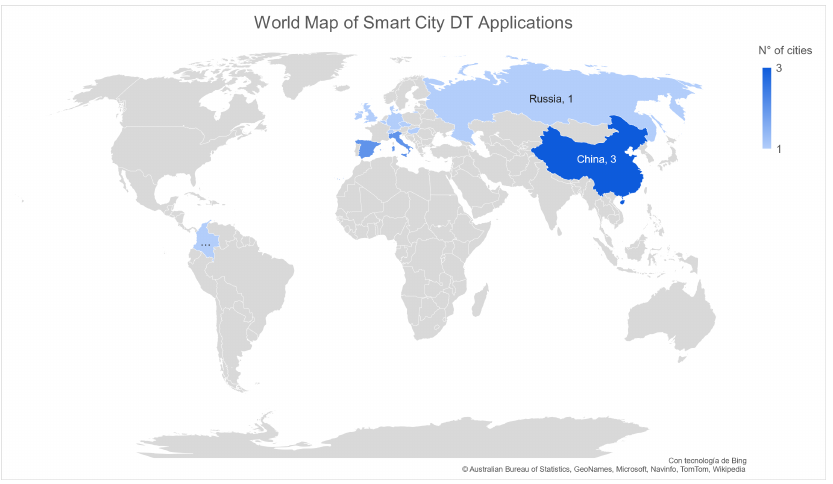
Figure 5. World map of smart city digital twin